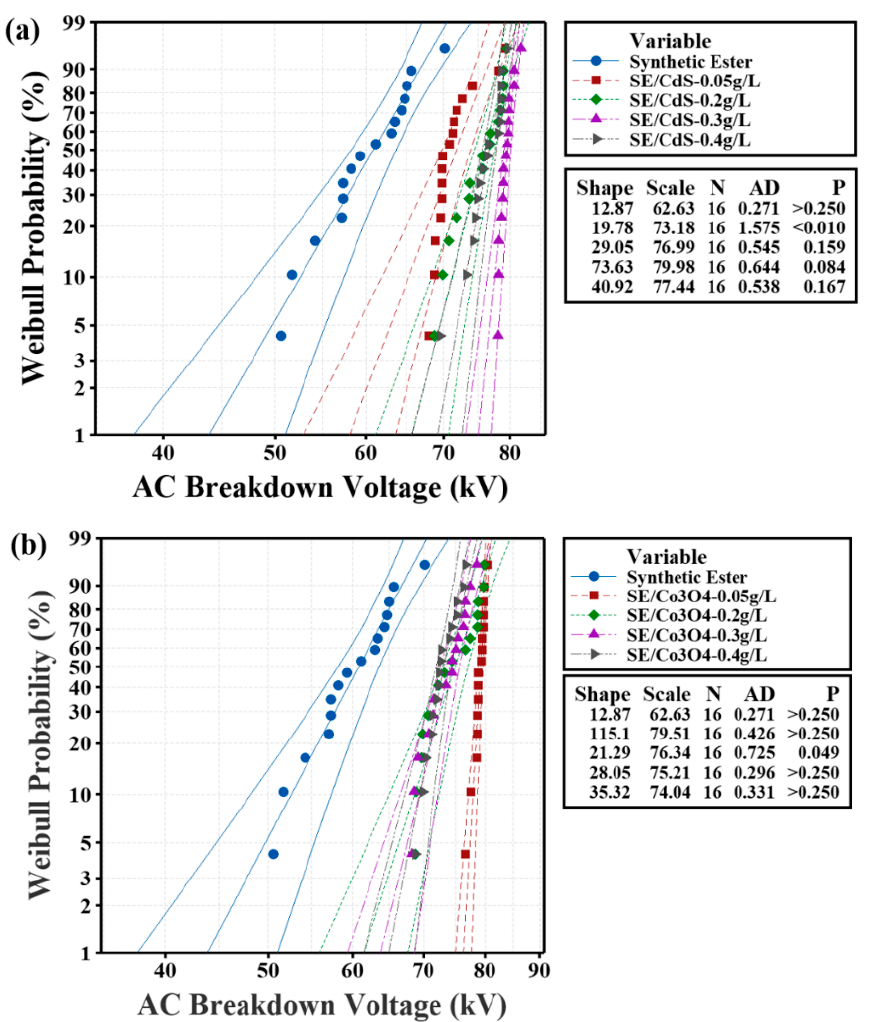
Figure 6. Weibull probability distribution plot of AC breakdown voltages of ( a ) SE/CdS and ( b ) SE/Co 3 O 4 , compared with synthetic ester. Table 3. Conformity of average AC breakdown voltage to a Weibull distribution for synthetic ester and nanofluids.